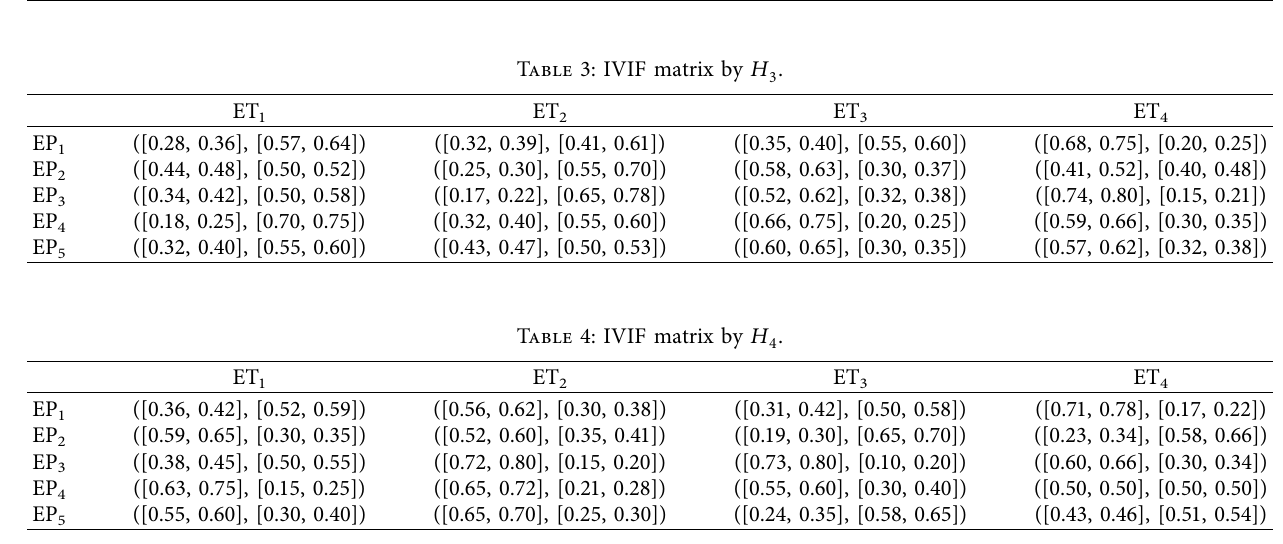
Table 3: IVIF matrix by H